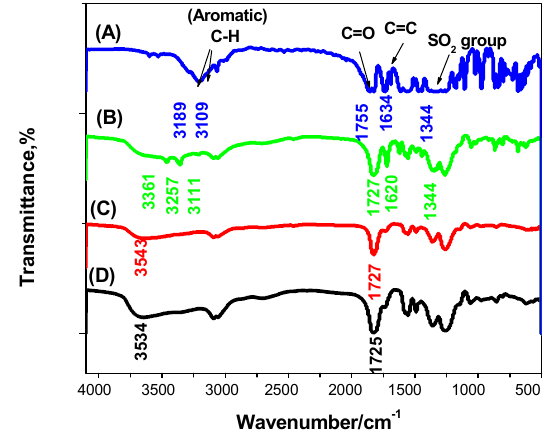
Figure2. FT-IRspectrafor( A )flucarbazone(FLU),( B )non-washedMIP;( C )washedMIP;( D Figure 2. FT-IR spectra for ( A ) flucarbazone (FLU), ( B ) non-washed MIP; ( C ) washed MIP; ( D ) NIP beads.